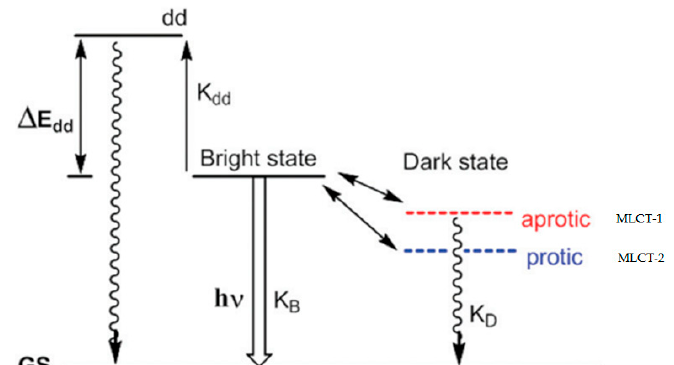
Figure 3. Mechanism of the molecular light switch proposed by Olson et al. Reproduced with permission from the authors of [14]. Copyright © 1997, American Chemical Society.